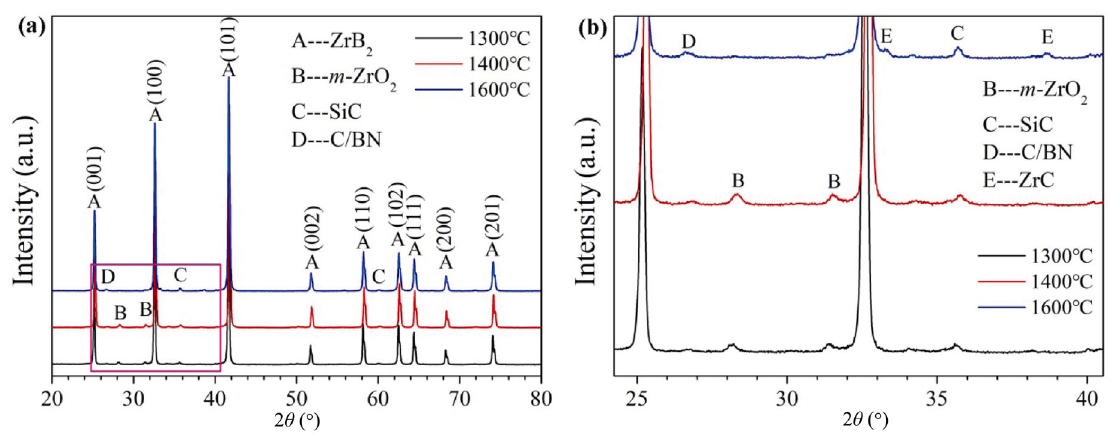
Fig. 3 (a) XRD patterns of ZrB 2 –SiBCN ceramics with 1 wt% ZrO 2 sintered at different temperatures for 90 min and (b) the large magnification of rectangular area in